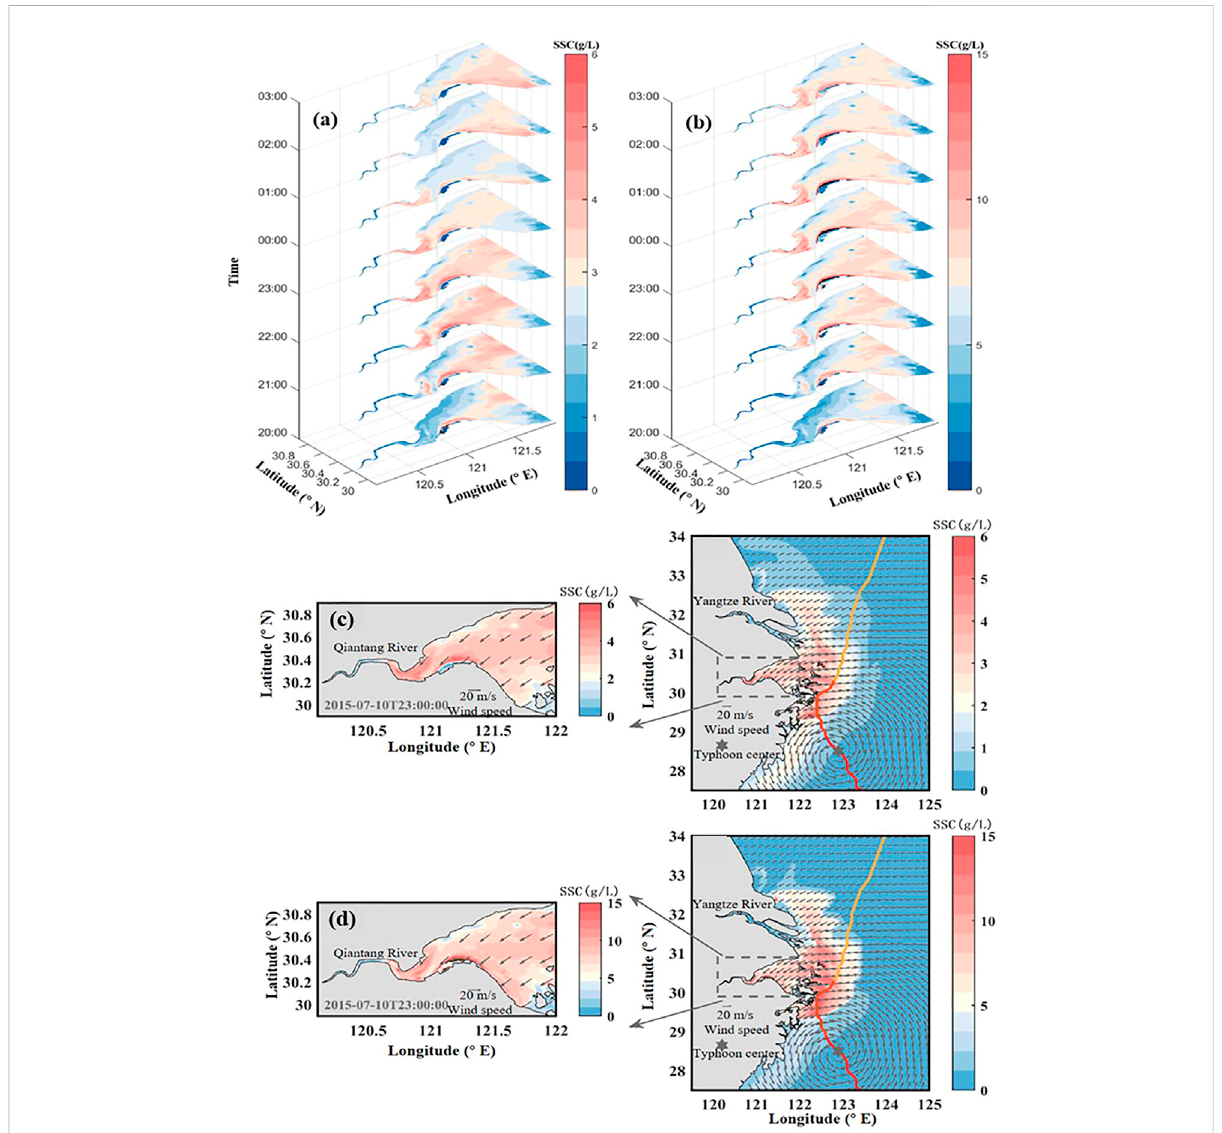
FIGURE 6 Time-seriesofSSCdistribution inthesurfaceand bottomlayer (20:00on10 July2015 to03:00 11July 2015): (A) surfaceand (B) bottomlayers. SSC distribution in the (C) surface and (D) bottom layers at 23:00 on 10 July 2015. The vector indicates